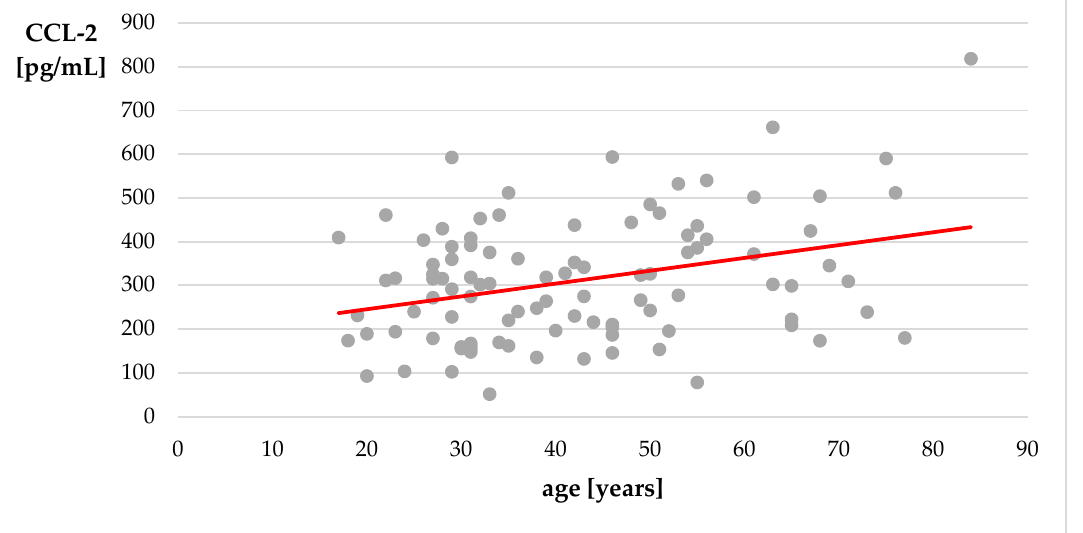
Figure 2. Correlation of age with level of CCL-2—control group. Spearman’s correlation coefficient. Serum levels of TIMP-2 were higher in women both in the research and in the control group. Mean serum levels of TIMP-2 in women with epilepsy were 155.91 ± 5.52 ng/mL, median 149.97 ng/mL vs. 142.13 ± 5.46 ng/mL and 133.84 ng/mL in men ( p = 0.0172). In the control group, mean serum levels of TIMP-2 in women were 128.03 ± 4.93 ng/mL, median 124.84 ng/mL and in men 111.54 ± 5.03 ng/mL, median 111.14 ng/mL ( p = 0.0015; Figure 3). Figure 3. Sex-related differences in serum level of TIMP-2 in ( a ) patients with epilepsy and ( b ) con- trol group. Box plot. The GLMMs confirmed the sex-related differences in TIMP-2 levels in the research group (least squares means; women: 155.30 ± 4.65 ng/mL, men: 143.91 ± 4.53 ng/mL, p = 0.0397). Additionally, higher levels of S100B were observed in men. Mean level of S100B in men was 77.62 ± 13.13 pg/mL, in women 40.89 ± 6.58 pg/mL ( p = 0.0061, least squares means). 3.5. Correlation between the Serum Levels of BBB-Associated Proteins There was a strong positive correlation between the serum level of MMP-9 and MMP- 9/TIMP-1 ratio, and between the level of MMP-2 and MMP-2/TIMP-2 ratio. The level of